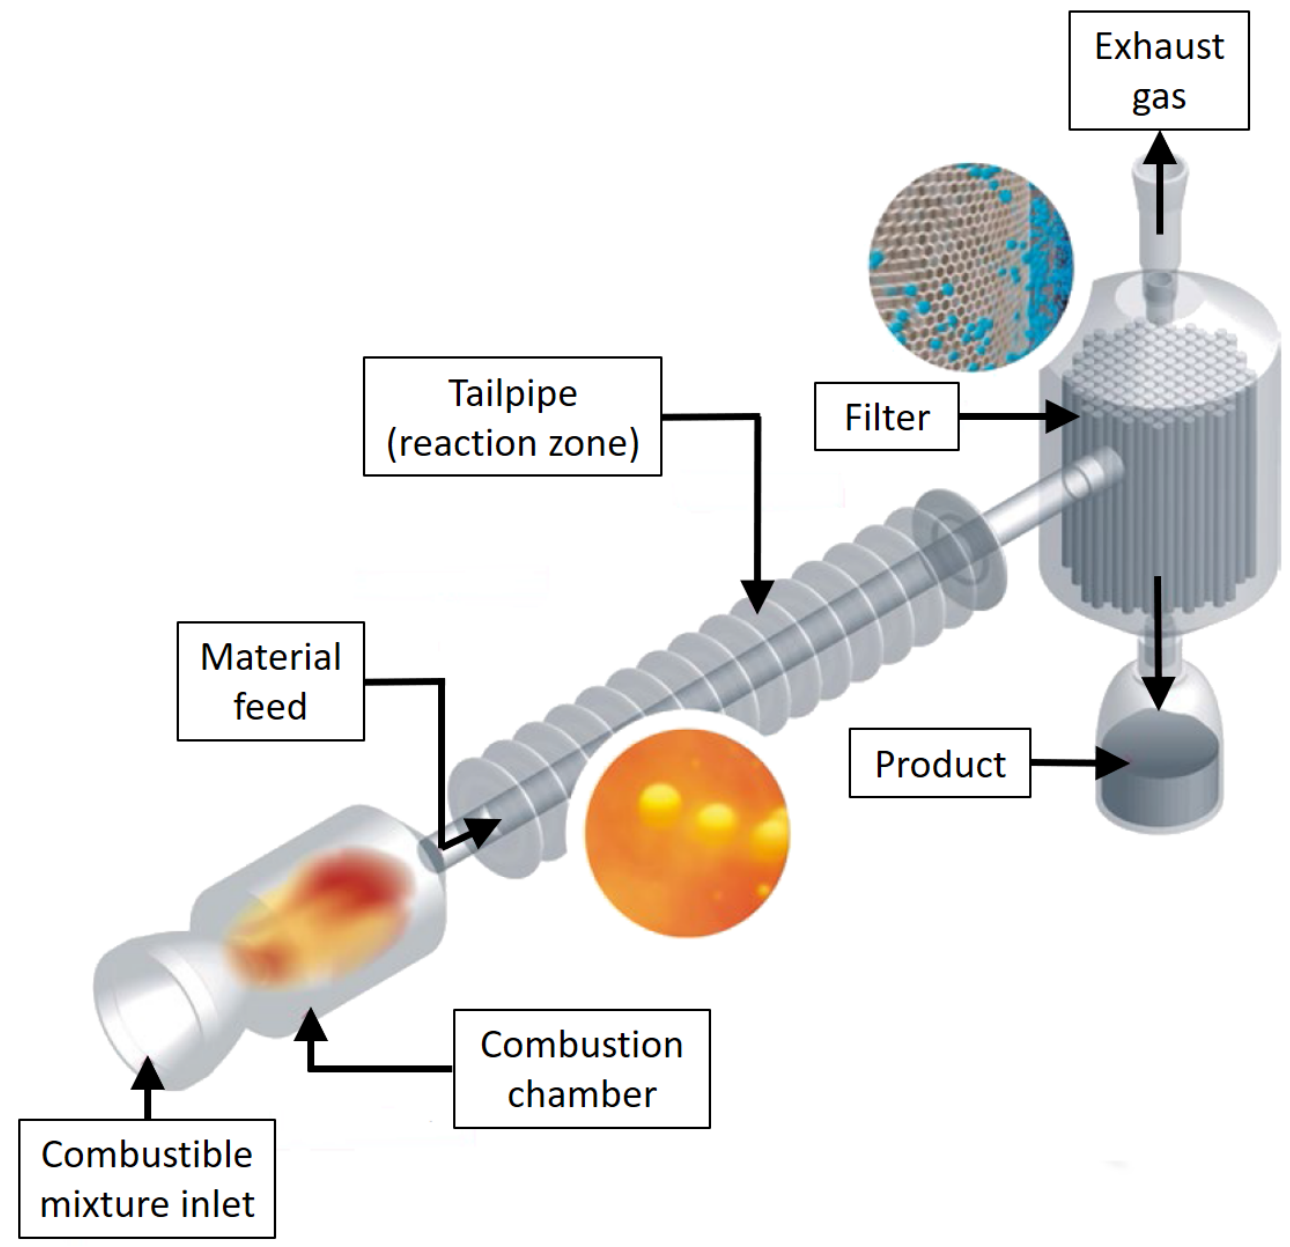
Figure 1. Schematic of a pulsation reactor